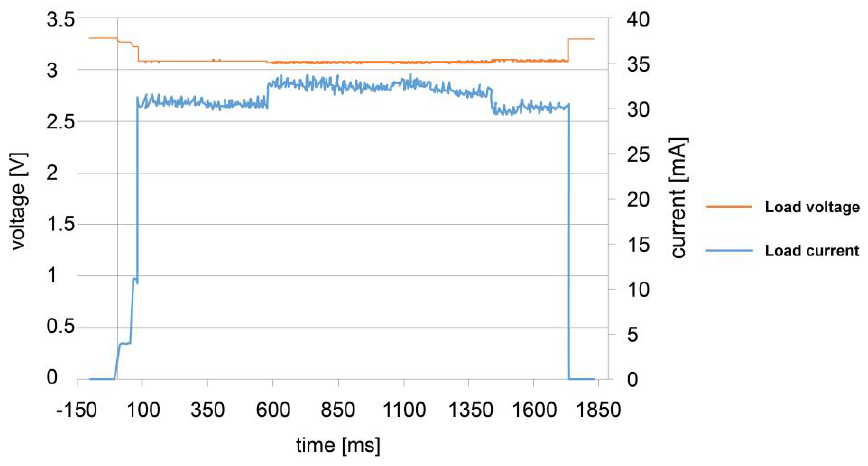
Figure 6. Load voltage and current consumption.